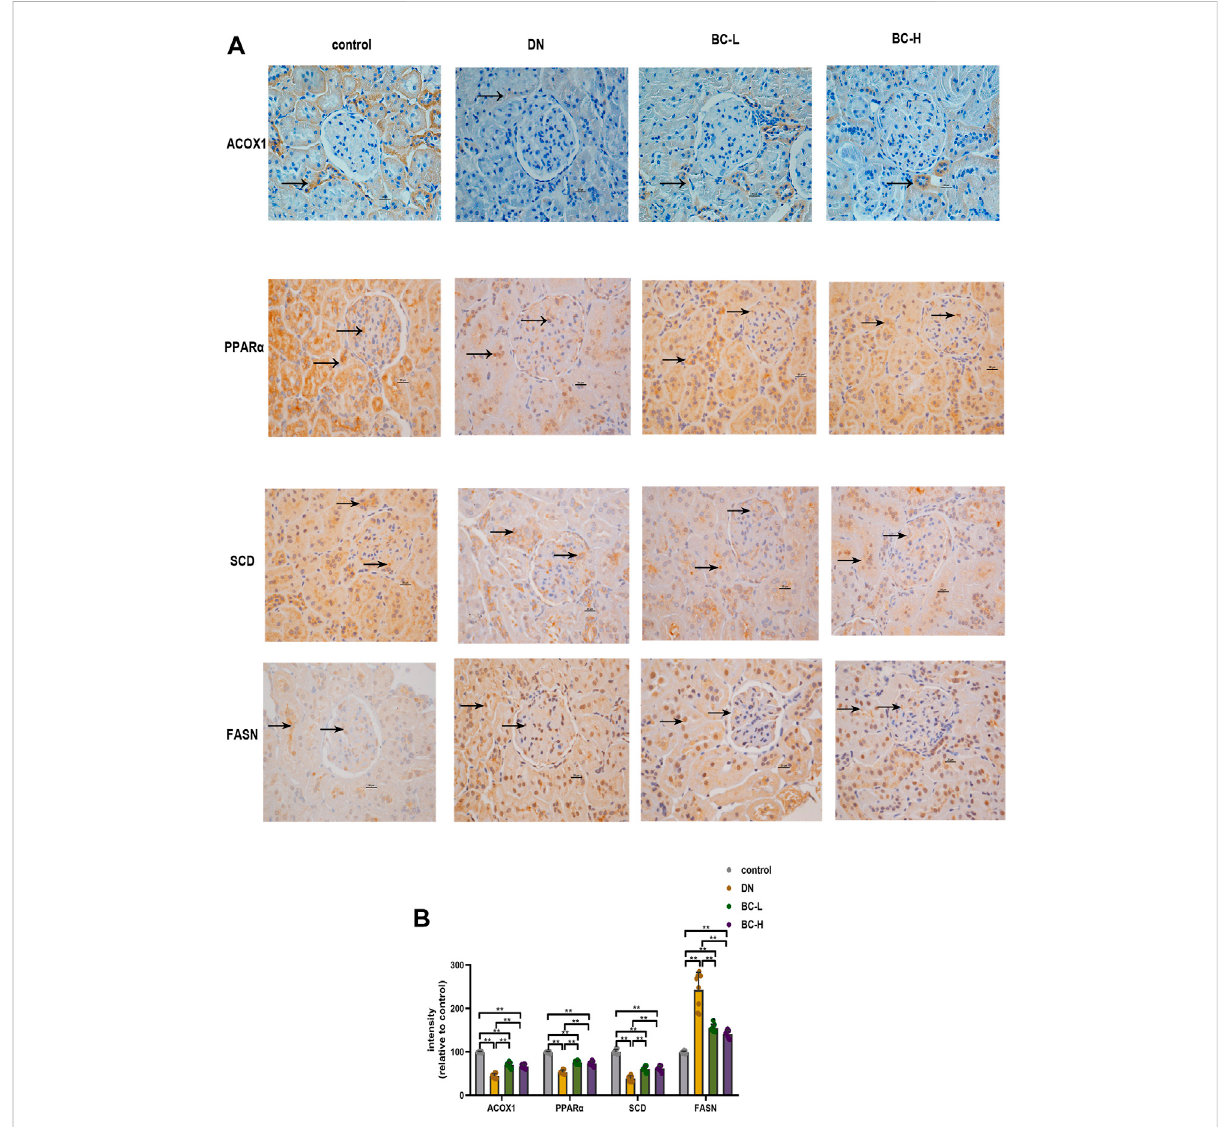
FIGURE 9 Effect of Bailing Capsule treatment on the expression levels of PPAR (peroxisome proliferator activated receptor) pathway in kidneys of rats shownbyimmunohistochemistrystaining. (A) RepresentativeimmunohistochemistrystainingforACOX1,PPAR α ,SCD,andFASN(400X).Scalebar= 20 μ m. Black arrows showed ACOX1 (+), PPAR α (+), SCD (+) and FASN (+) cells in the kidney. Immunohistochemistry staining showed that Bailing CapsuleincreasedtheproteinlevelsofACOX1,PPAR α ,SCDandinhibitedtheproteinlevelsofFASNinDNrats. (B) IntensityofACOX1(+),PPAR α (+), SCD (+) and FASN (+) cells in kidney of rats. DN, diabetic nephropathy; BC-L, low dosage of Bailing Capsule; BC-H, high dosage of Bailing Capsule. Data are expressed as mean ± SD ( n = 8). ** p <